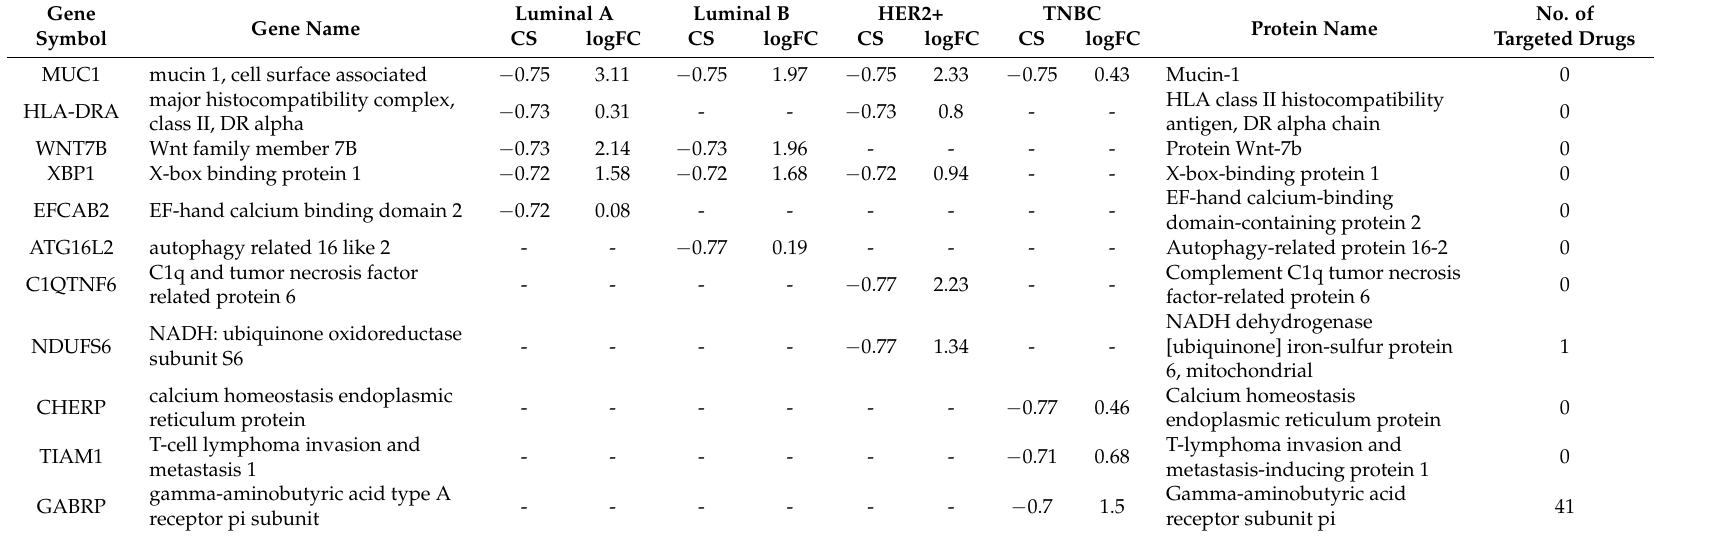
Table 1. Final candidate gene targets for four breast cancer